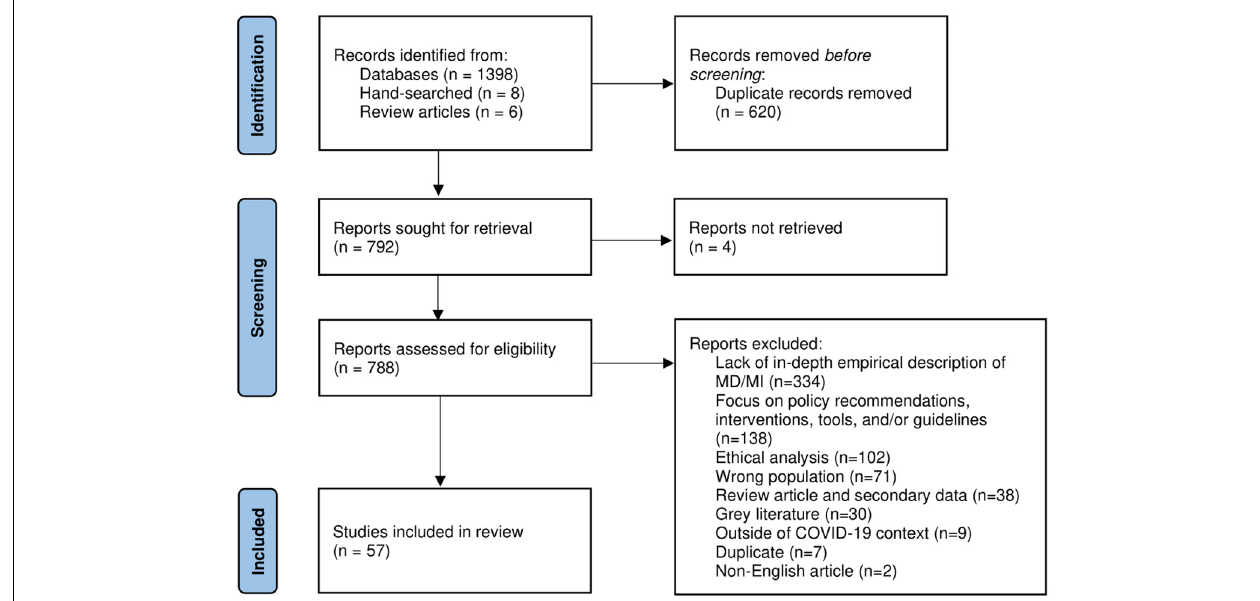
FIGURE 1 | PRISMA flow